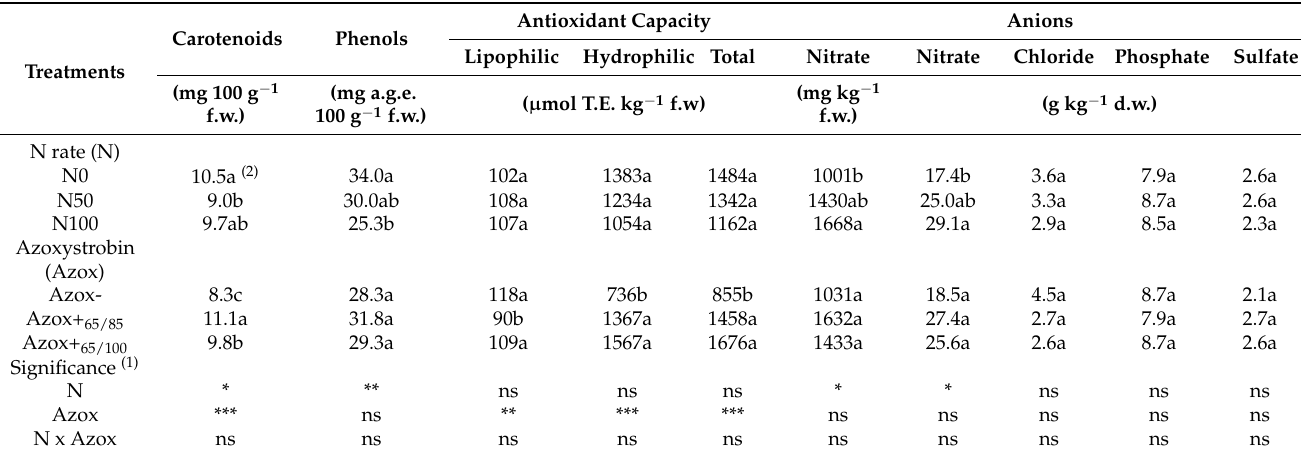
Table 3. Effect of N rate supply and Azoxystrobin application on nutritional and anti-nutritional traits of butterhead lettuce at